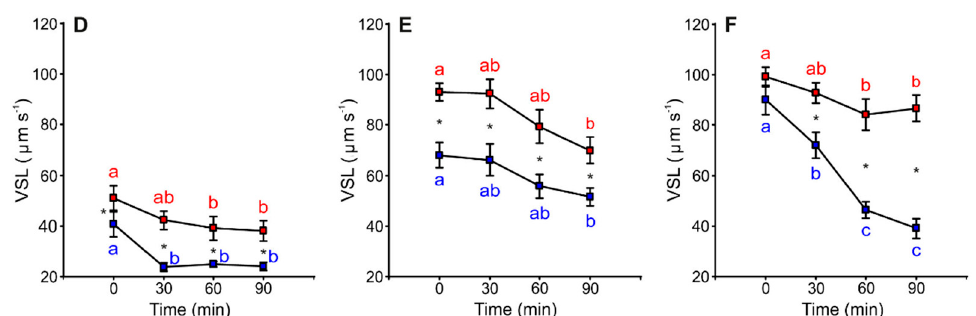
Figure 3. Variation in sperm swimming parameters (VCL and VSL) from three mouse species ( M. musculus , M. spretus , M. spicilegus ) incubated under non-capacitating conditions (mT-H medium) and capacitating conditions (mT-BH medium). Data are means ± SE ( n = 7 in M. musculus , n = 8 in M. spretus , and n = 6 in M. spicilegus ). Red squares: non-capacitating conditions, mT-H medium under air. Blue squares: capacitating conditions, mT-BH medium under 5% CO 2 /air. ( A – C ) Curvilinear velocity (VCL) (µm s − 1 ). ( D – F ) Straight-line velocity (VSL) (µm s − 1 ). ( A , C ) M. musculus . ( B , E ) M. spretus . ( C , F ) M. spicilegus . Asterisks indicate significant differences ( p < 0.05) between treatments for the same time in a Fisher post-hoc test. Different letters between times of incubation for the same treatment indicate statistically significant differences ( p < 0.05) in a Fisher post-hoc test. If two time-points of an incubation share any letter, the differences between them are not significant. No letters were used when a time-point of an incubation did not show any significant effect in the dependent variable.